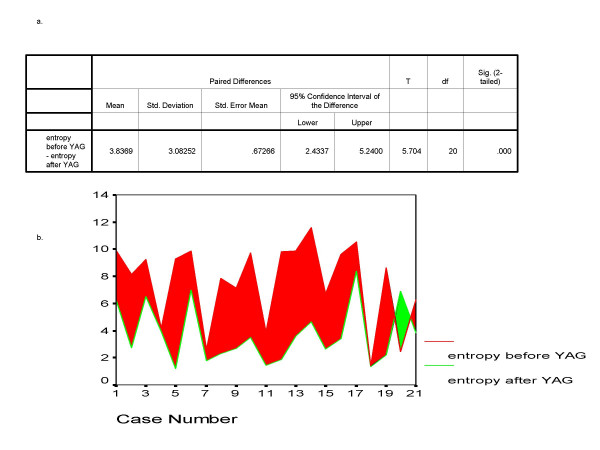
Comparison of AA scores of patients before and after Nd:YAG capsulotomy; a. Statistical analysis, b. Graphically displayed